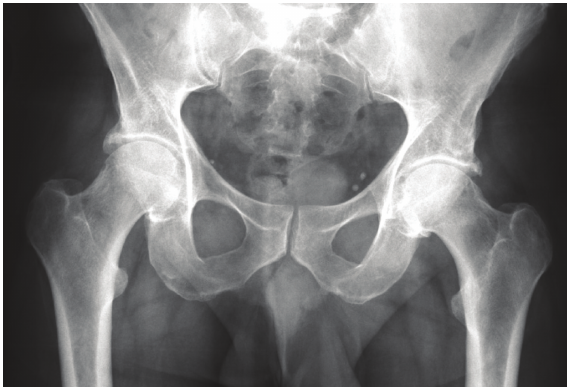
Figure 1: X-ray at admission.